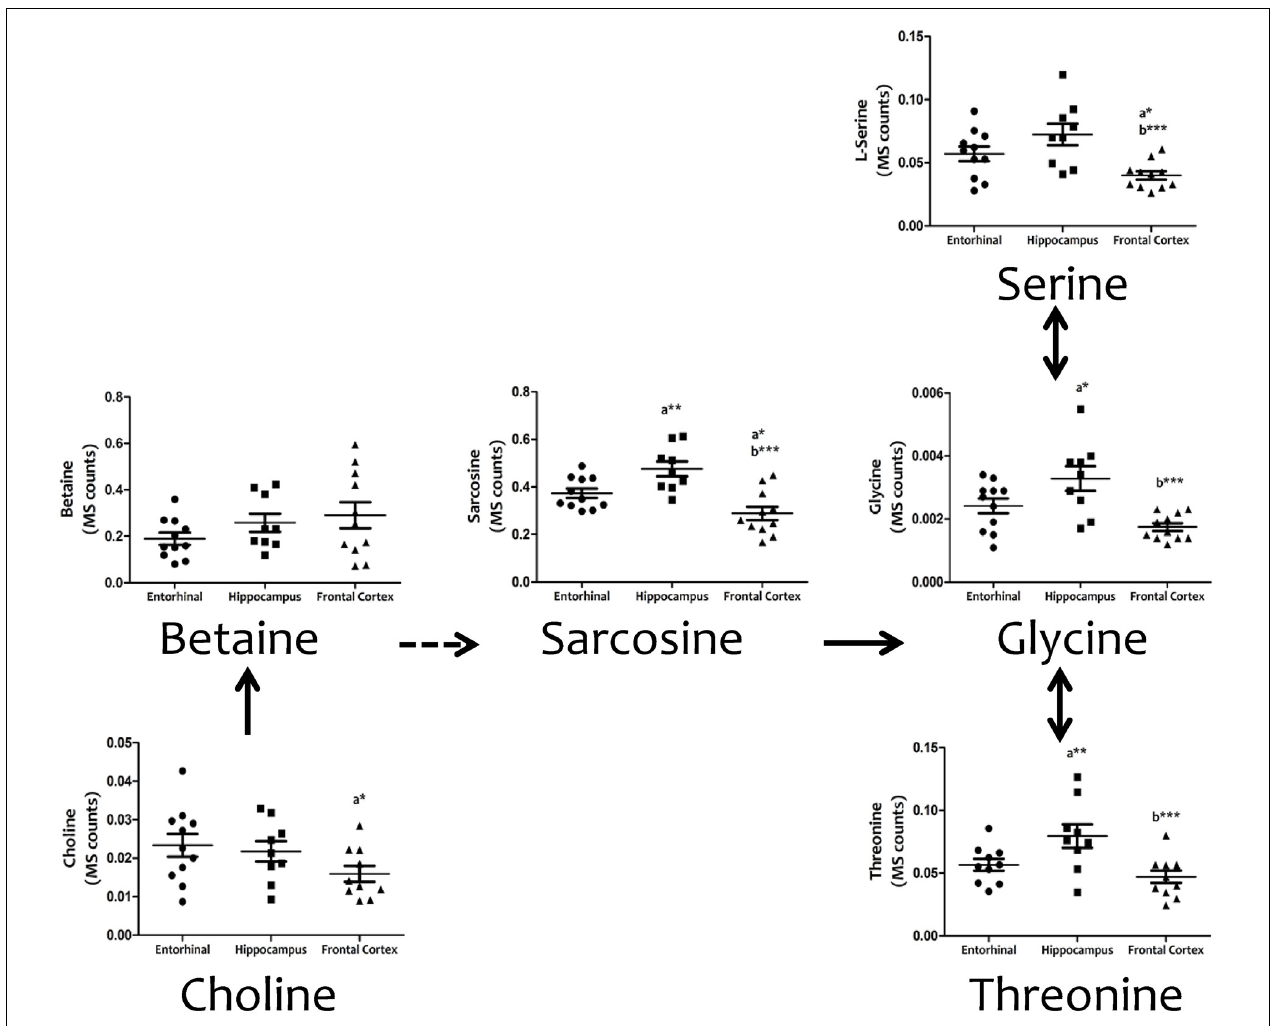
FIGURE 3 | Tissue concentrations of metabolites from the serine, glycine and threonine metabolism in different regions of the adult human cerebral cortex. All metabolites were measured with TQMS. ∗ p < 0.05; ∗∗ p < 0.01; ∗∗∗ p < 0.001. a, significant differences with respect to entorhinal cortex; b, significant differences with respect to